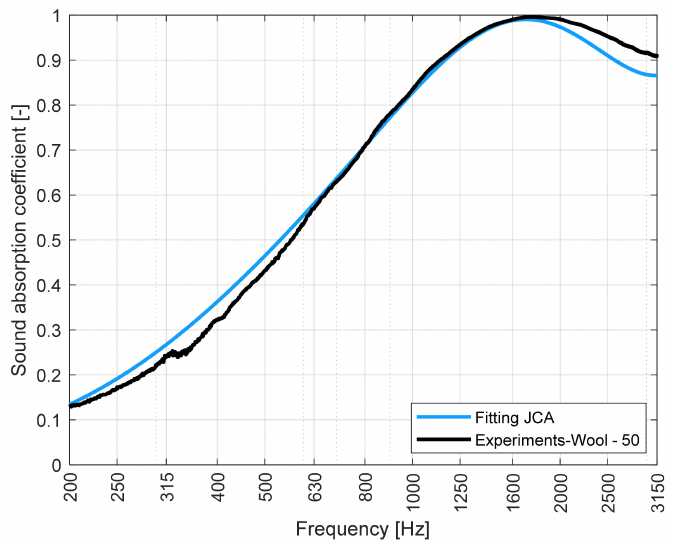
Figure 11. Comparison between experimental and predicted sound absorption coefficient for the wool sample derived from white